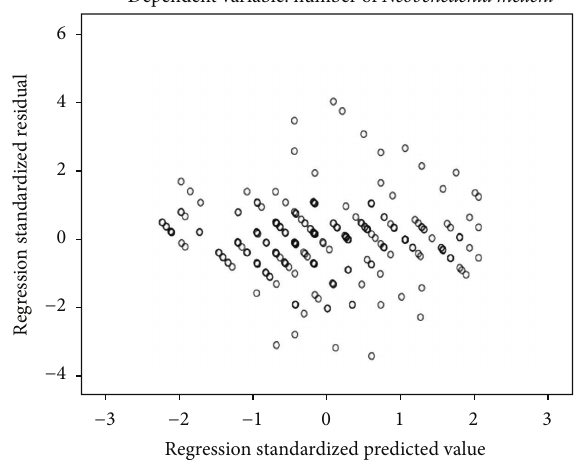
Figure 12: The figure shows that the points are randomly and evenly dispersed and do not have any specific pattern indicating that there is homoscedasticity or homogeneity of variance and linearity assumption is